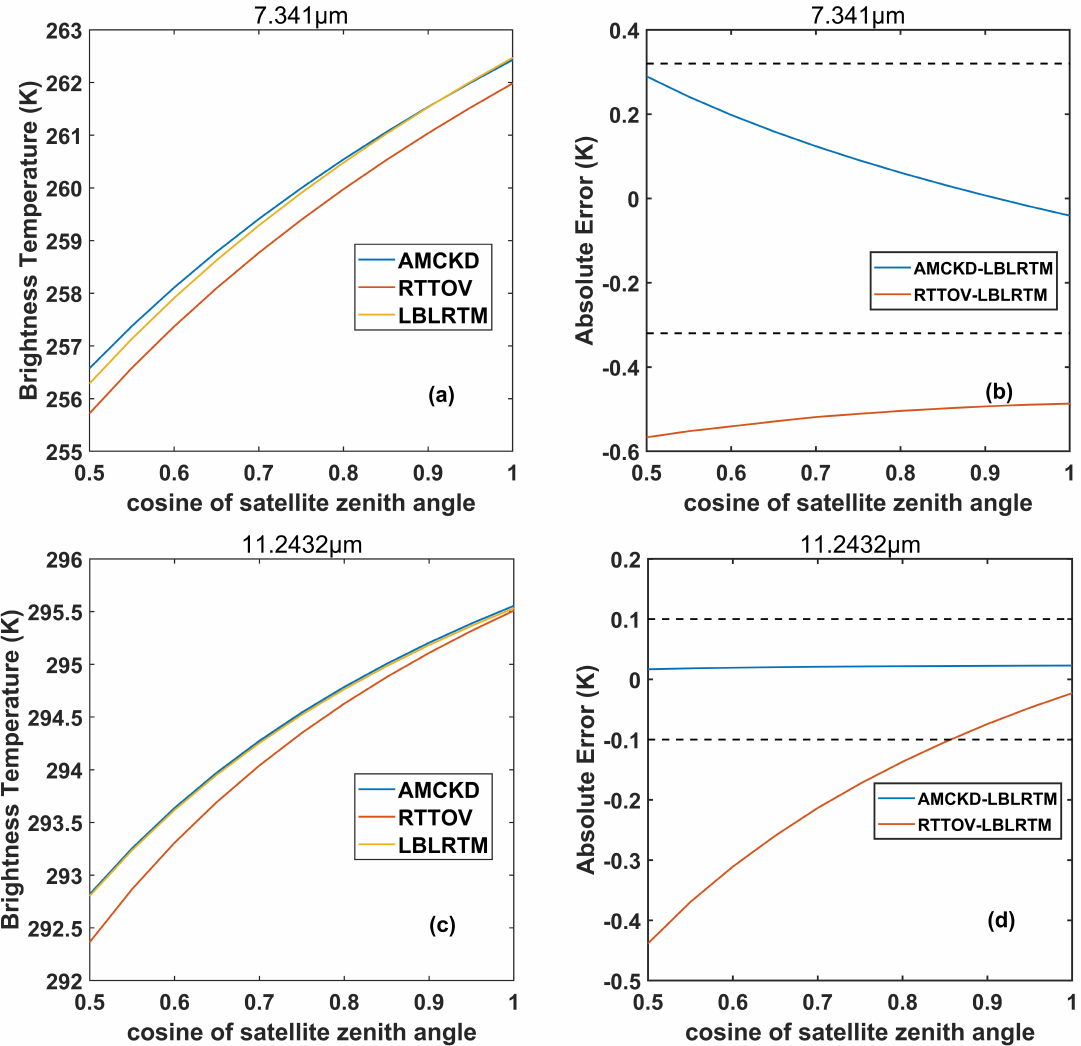
Figure 3. Left column ( a , c ): the brightness temperatures of AHI vs the cosine of viewing zenith angles for the 7.3471 μm channel ( a ) and the 11.2432 μm channel ( c ); right column ( b , d ): the differences of AMCKD–LBLRTM and RTTOV–LBLRTM. The dash lines are NEDTs.